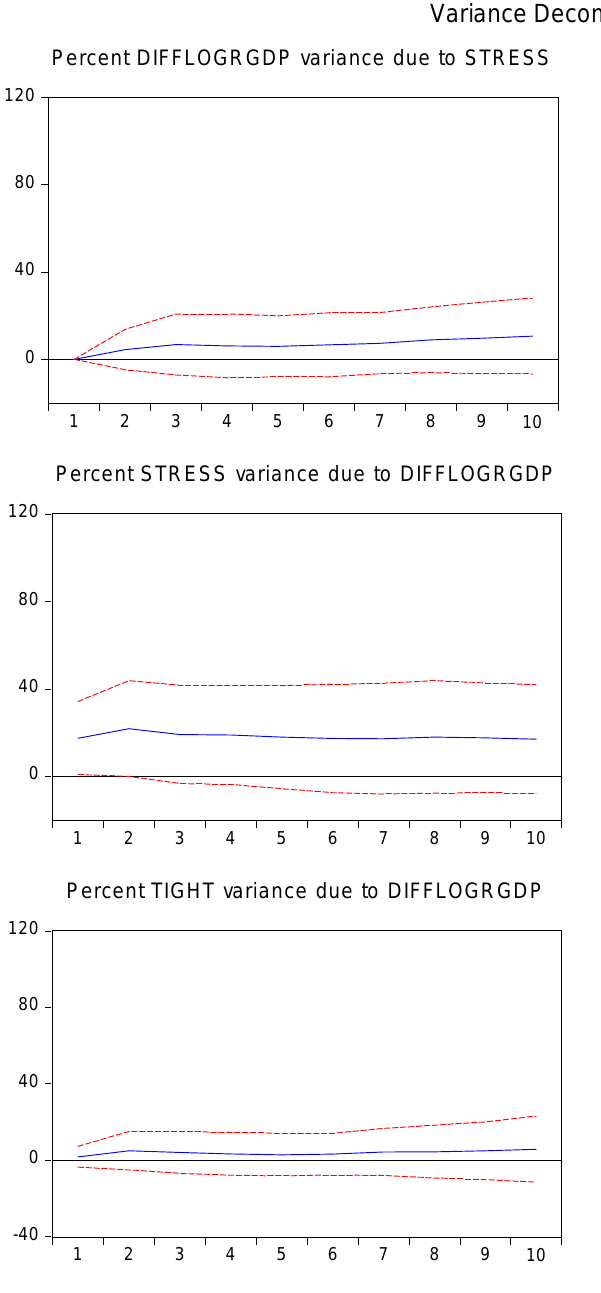
Figure 6. Variance decomposition results for the three variable VAR with seven lags. The red lines are 5% confidence